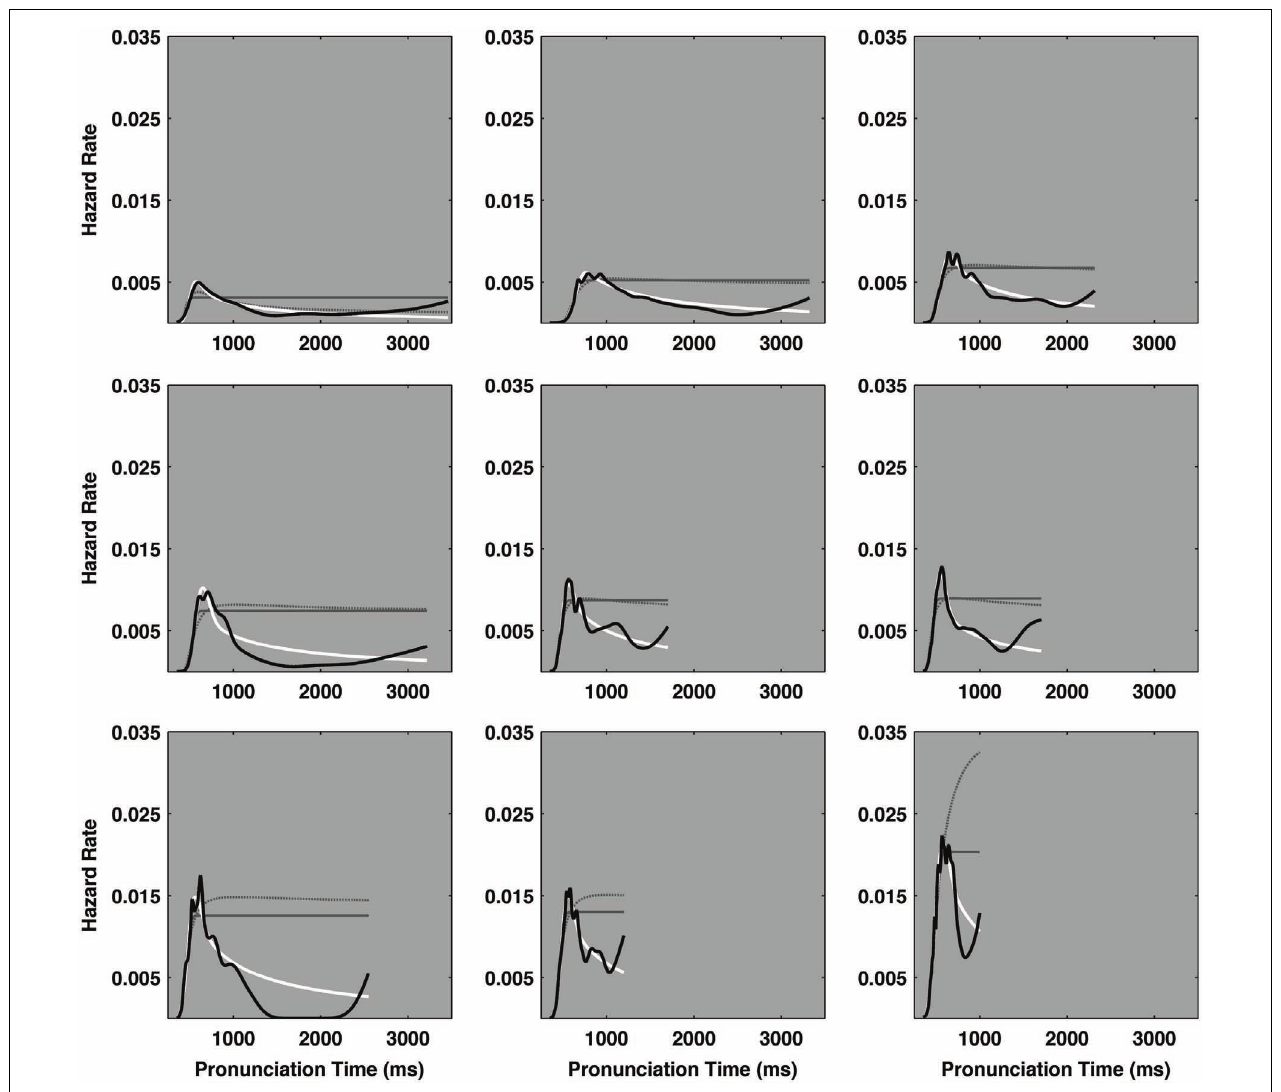
and ex-Wald hazard functions were effectively identical.The majority of the empirical hazard functions entail a peak and their slow tails more closely match the power law decay indicated in the cocktail description than the exponential decay indicated by either the ex-Gaussian or ex-Wald alternatives. The distribution in the top left plot yielded the smallest power law scaling exponent ( α = 3.44), the bottom right plot yielded the largest scaling exponent ( α = 11.36). α = power law scaling